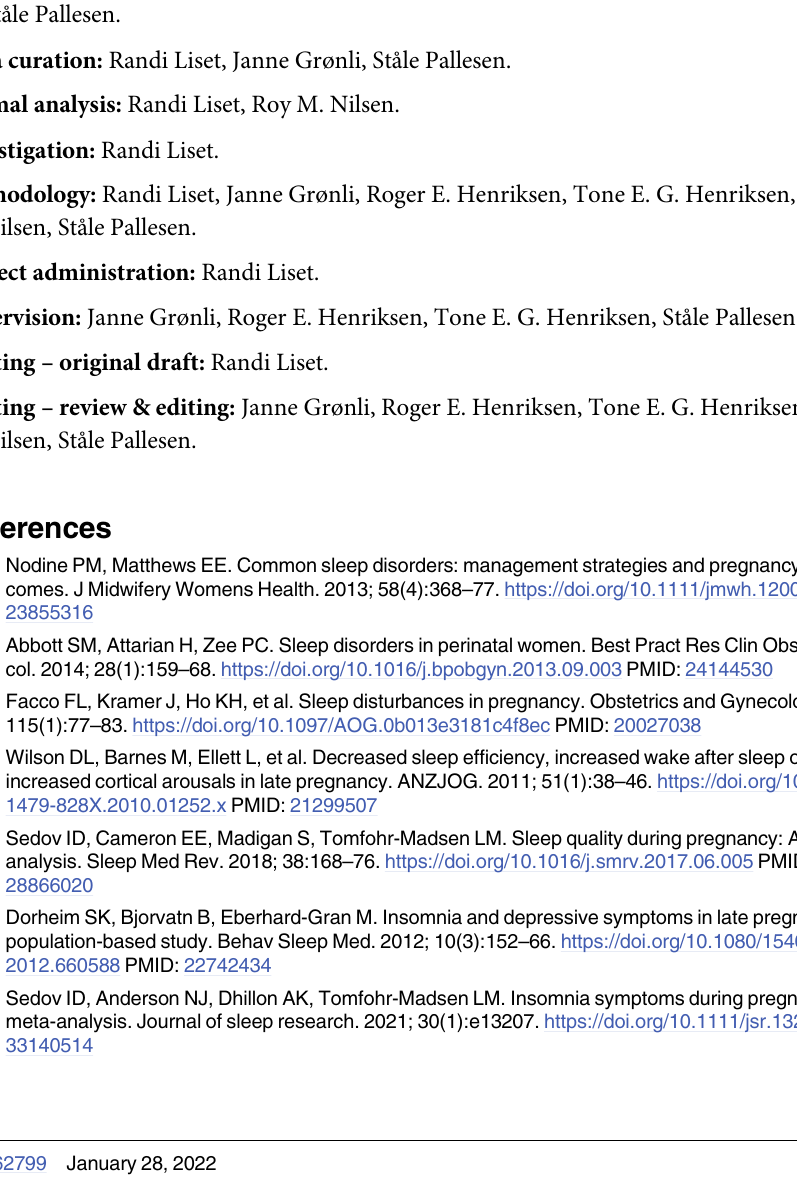
S1 Dataset. Table 1, supporting table and Fig 3. S2 Dataset. Table